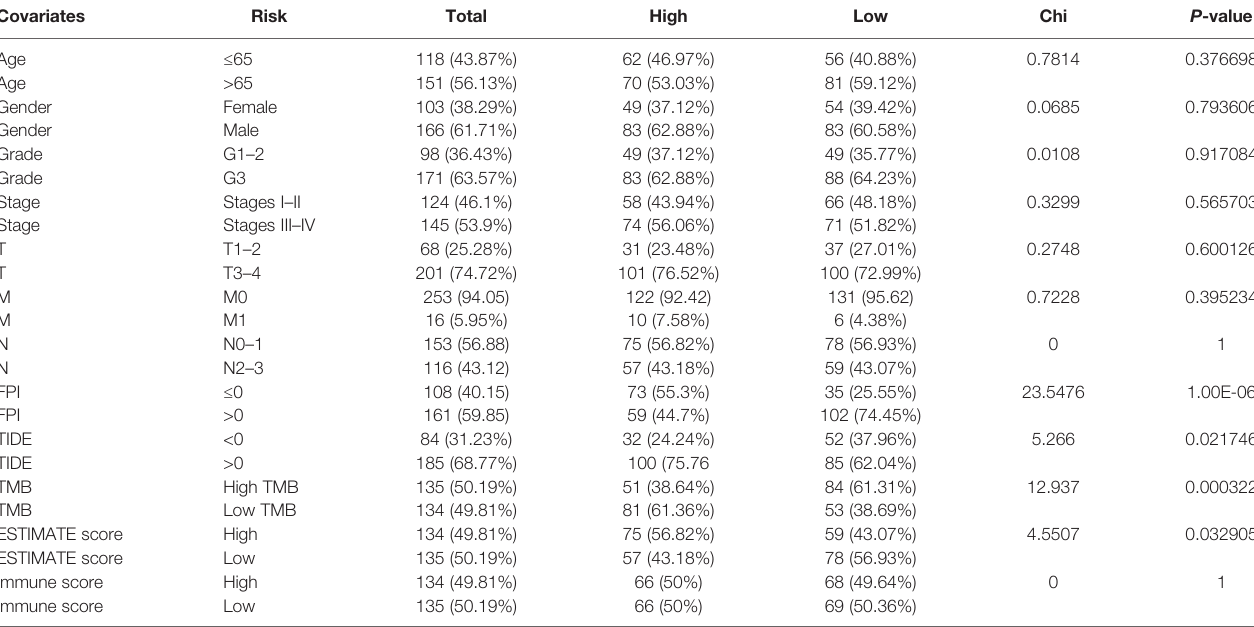
TABLE 3 | Risk based chi-square test of clinical characteristics. Covariates